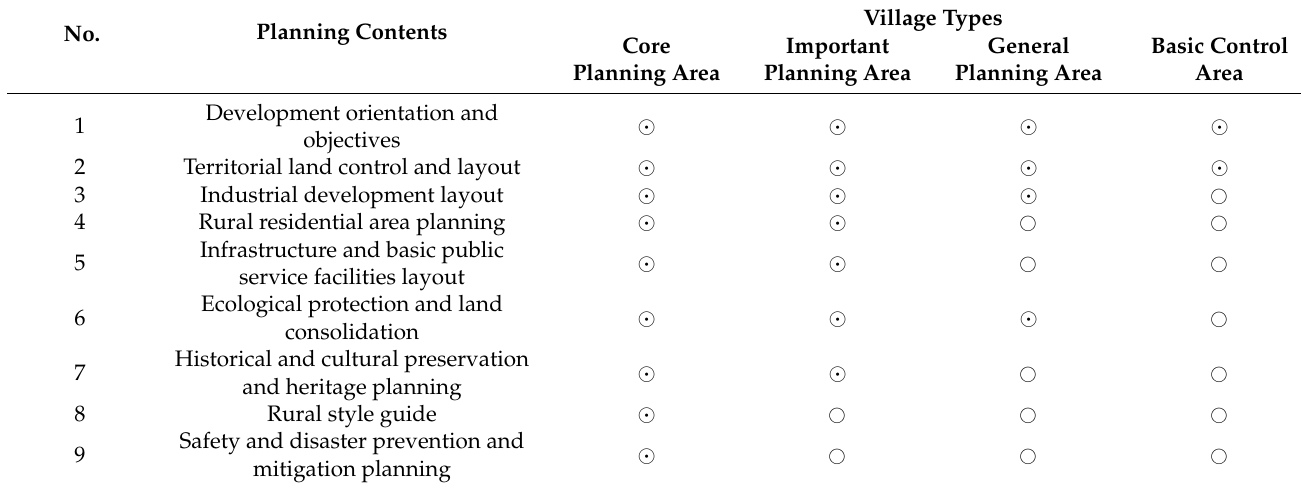
Table 3. Contents of practical village